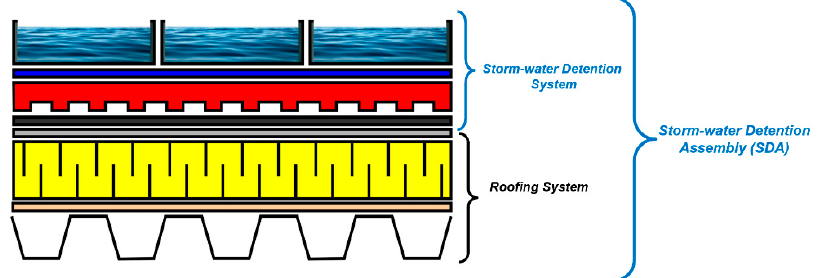
Figure 1. Typical components of a Storm-water Detention Assembly